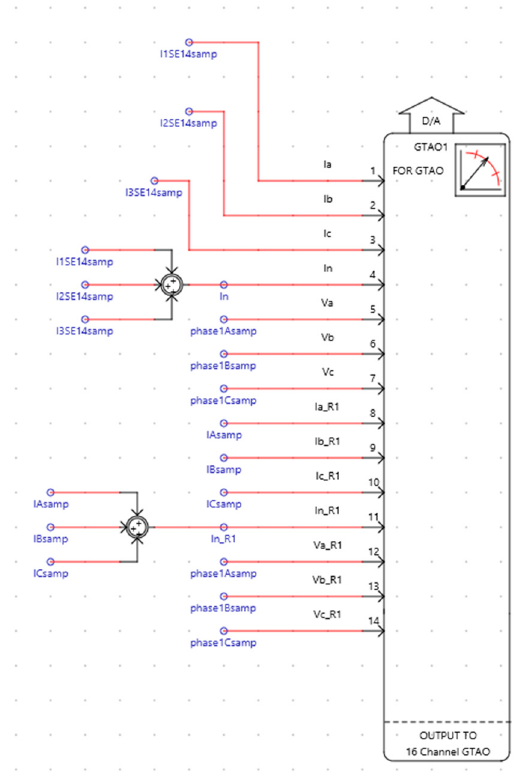
Figure 10. GTAO element in the RSCAD model.